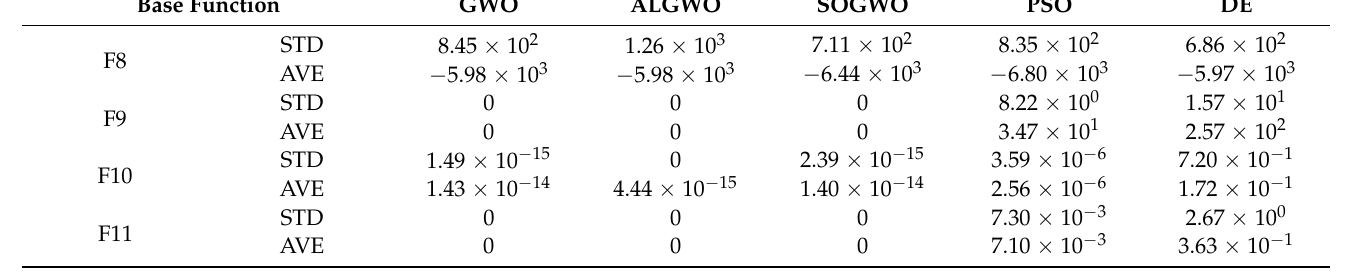
Table 5 contains the average and standard deviation for ten independent runs. The convergence rates of the four test functions for several algorithms are displayed in Figure 8.